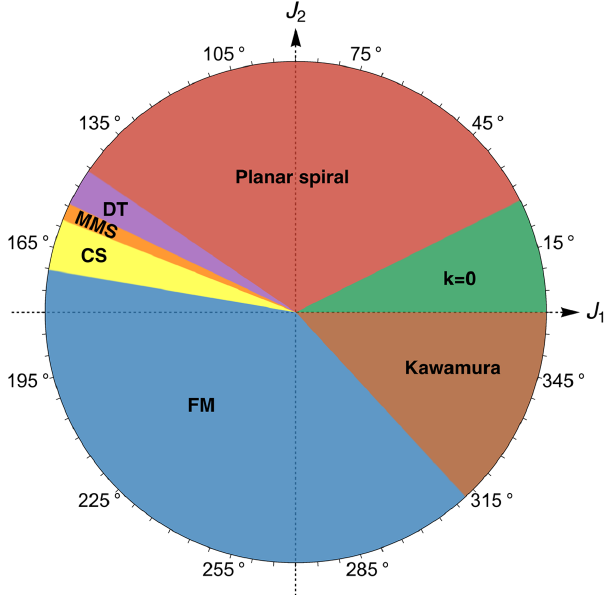
FIG. 15. The classical phase diagram of the J 1 - J 2 Heisenberg model on the pyrochlore lattice. The couplings are parametrized as J 1 ¼ J cos ð θ Þ and J 2 ¼ J sin ð θ Þ with J an overall energy scale. See Table I for a description of the phases and the location of the phase